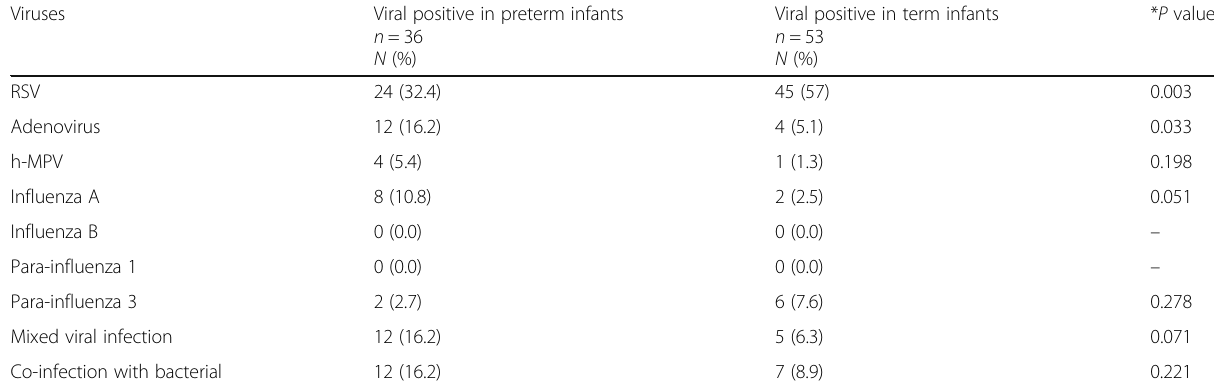
Table 3 Viral PCR results among preterm and term infants with bronchiolitis Viruses